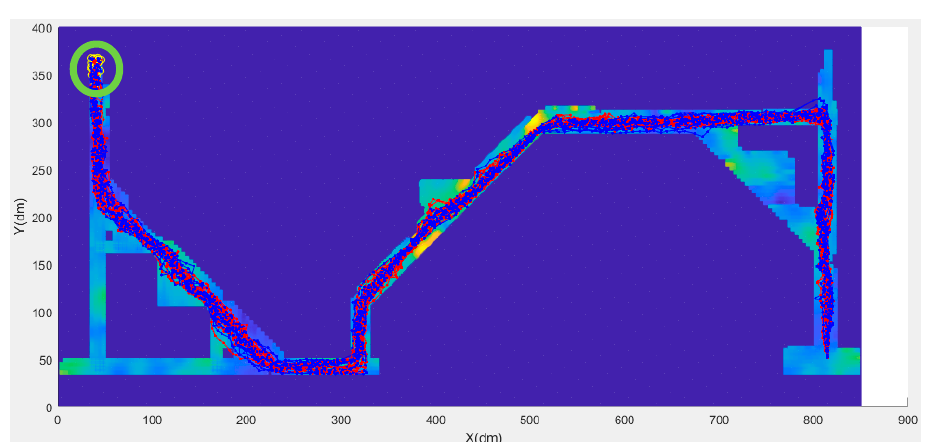
Figure 14. Test result of the 30 users (backward).